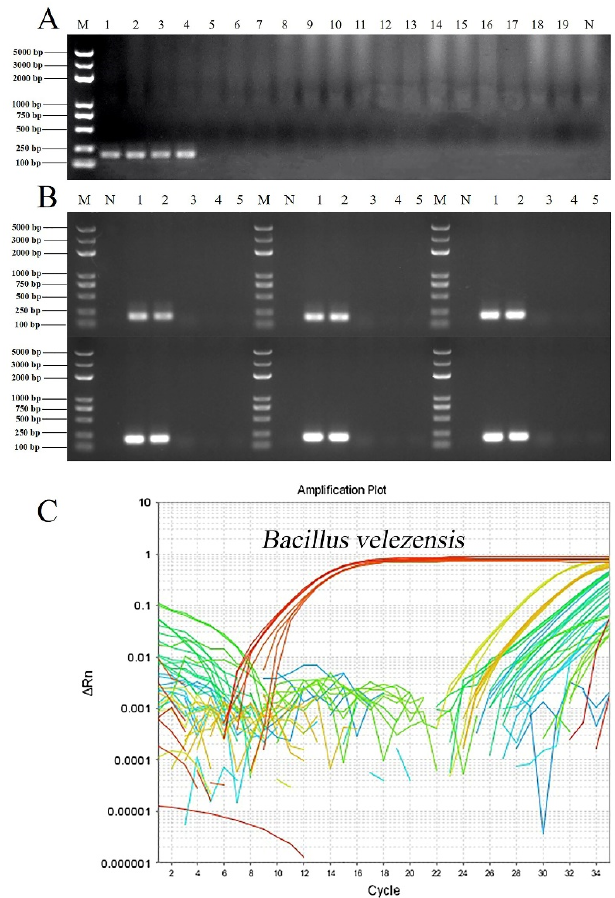
Figure 3. Verification of specific primers targeting B. velezensis among different bacterial strains. ( A ), PCR verification. M, DNA marker (from large to small was 5000 bp, 3000 bp, 2000 bp, 1000 bp, 750 bp, 500 bp, 250 bp, 100 bp); N, negative control; 1, amplification template of B. velezensis ZF2 genomic DNA; 2, amplification template of B. velezensis ZF128 genomic DNA; 3, amplification template of B.